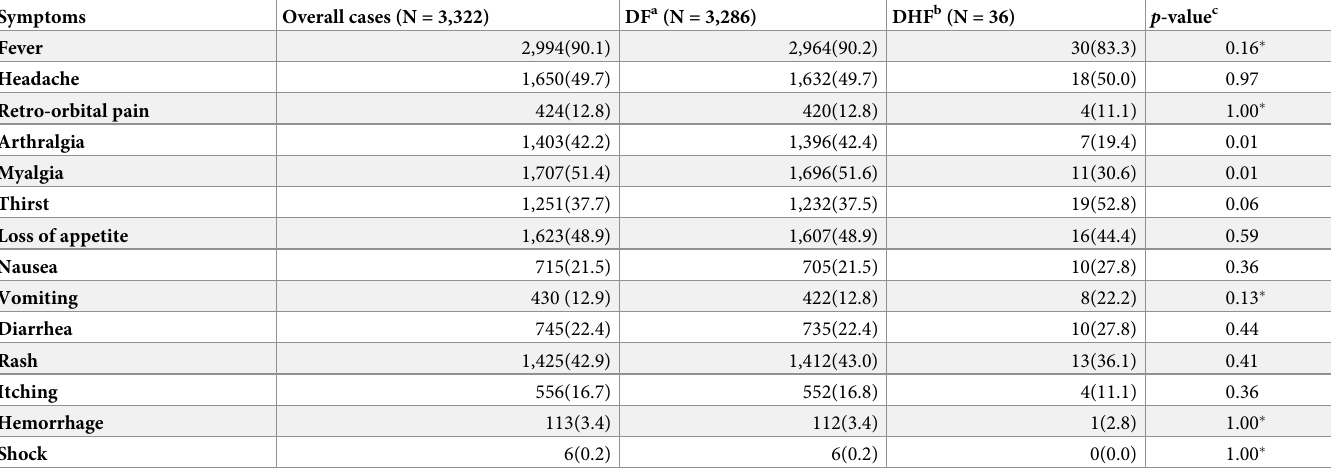
Table 3. Clinical manifestations of dengue-infected patients.